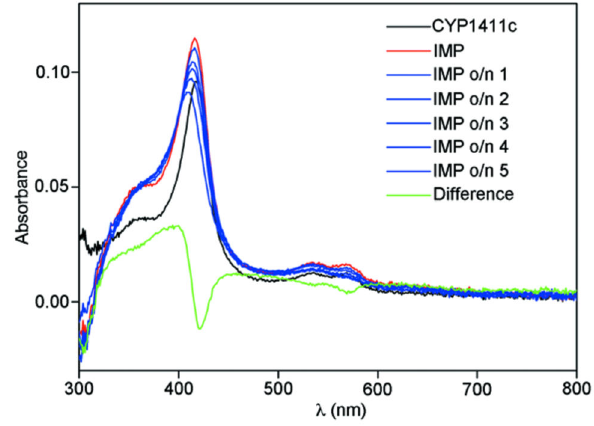
Figure 5. CYP1411c spectral change following incubation with the inner membrane fraction. IMP o/n 1-5 represent successive spectral recordings following incubation of purified CYP1411c protein with C. jejuni 81-176 inner membrane proteins. Spectra were recorded at 1 min intervals.